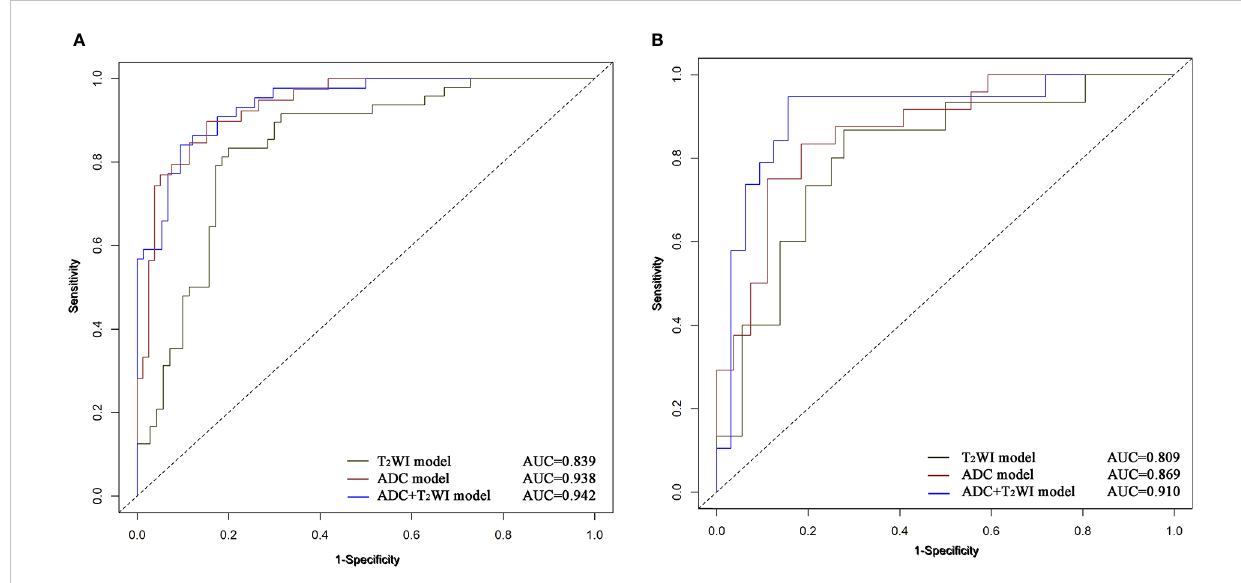
FIGURE 5 ROC curves of Logistic Regression classi fi ers using 3 radiomics models in the training (A) and validation (B) cohors.